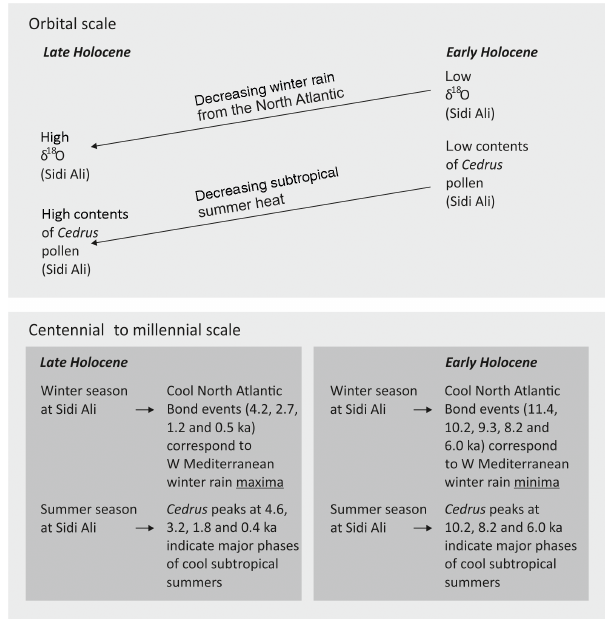
Figure 4. Holocene Lake Sidi Ali record: major conclusions of this